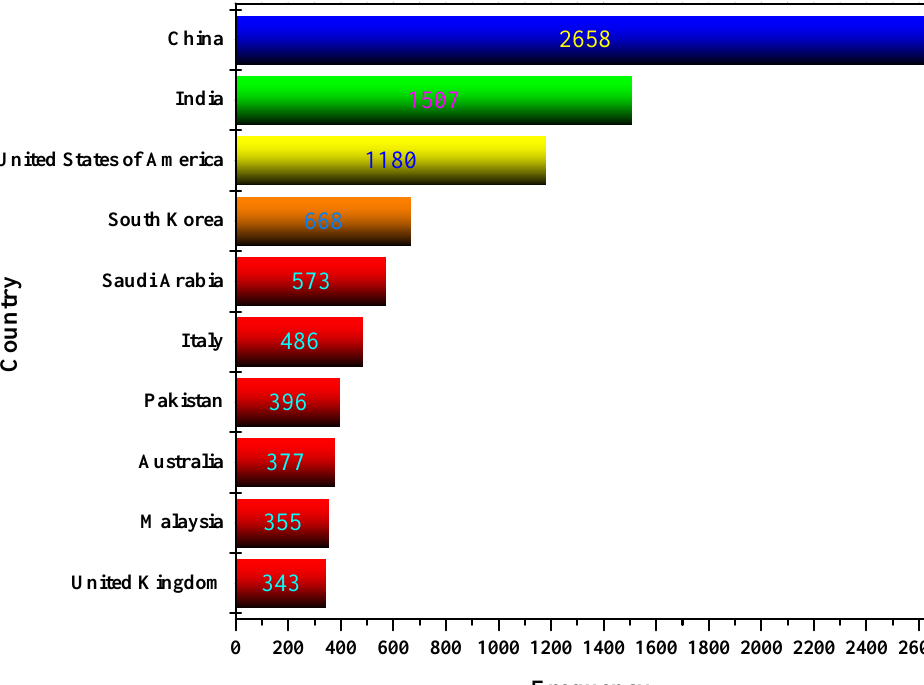
Figure 8. Scientific production by